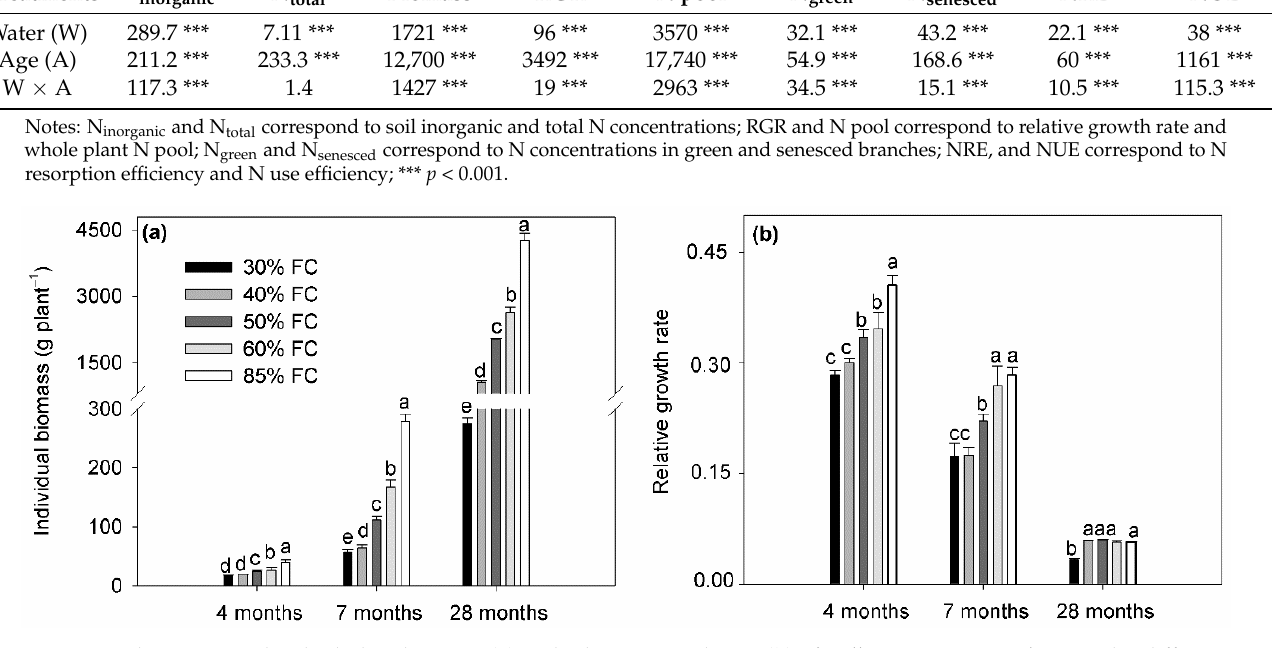
Figure 4. Changes in individual plant biomass ( a ) and relative growth rate ( b ) of Calligonum caput-medusae under different water treatments at three growth stages (4 months, 7 months, and 28 months). Values are shown as the means ± se ( n = 4). Bars with different lowercase letters indicate significant differences among treatments at the same growth stage at p < 0.05.